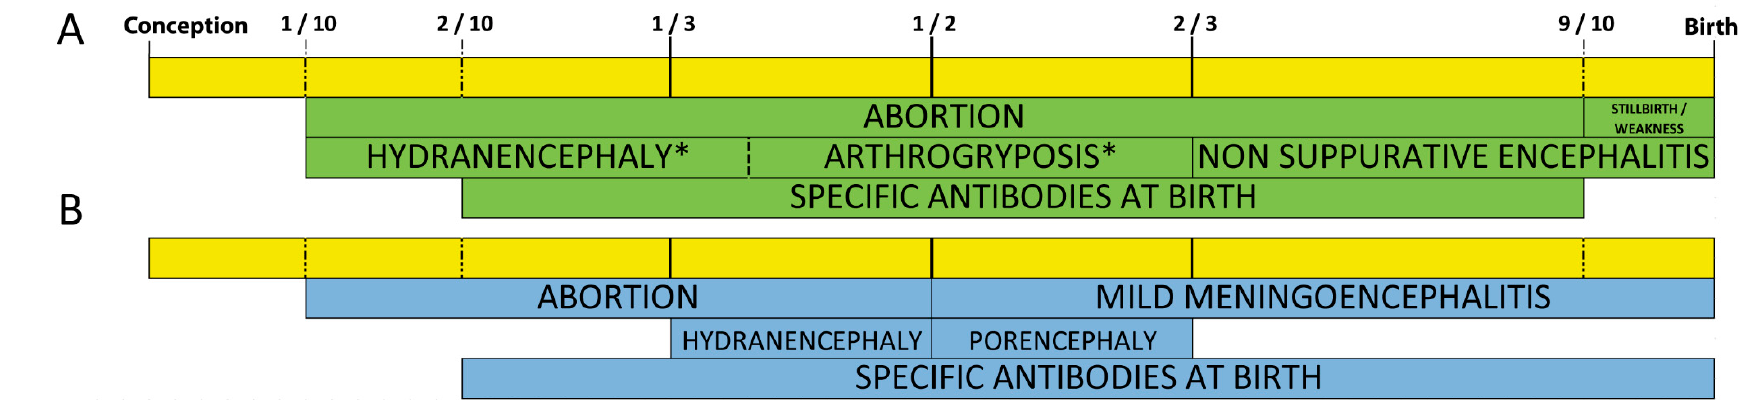
Figure 1. Schematic suggested timeframe for SBV ( A ) and BTV ( B ) in utero infection causing defects in cattle and small ruminants’ offspring [27,32,81,85,104,127,128] . In utero potential BTV (blue shades) and SBV induced defects (green shades) following infection of the pregnant dams along the whole gestation time for cattle and small ruminants. Time is expressed as a fraction of the total gestational time. A more detailed timeline is available as supplementary file.